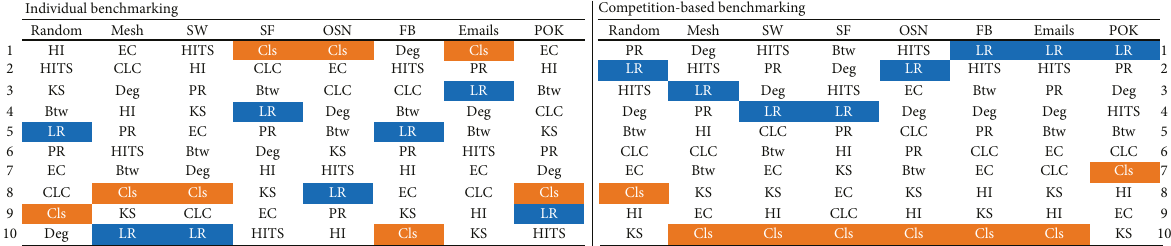
Figure 6: Visual representation of the uniformity in benchmarking in fl uence ranking methods across di ff erent networks. We highlight the positions obtained by LR (top centrality in terms of spreading) and Cls (least e ff ective centrality) across our 8 datasets in the context of individual (a) and competition-based (b) benchmarks. The position of a centrality on the vertical corresponds to its obtained rank (1 – 10) after benchmarking. For example, LR is the 5th best on random and 10th best on